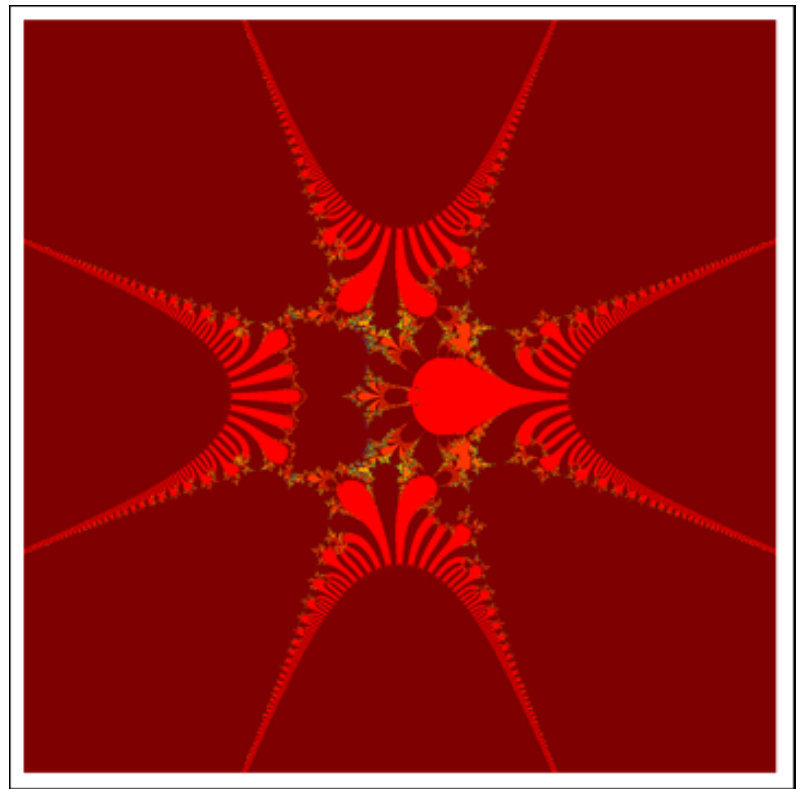
Figure 30. M-set for τ ( z ) = e z 4 + c via DKIS. The image execution time is 1495.8 s.